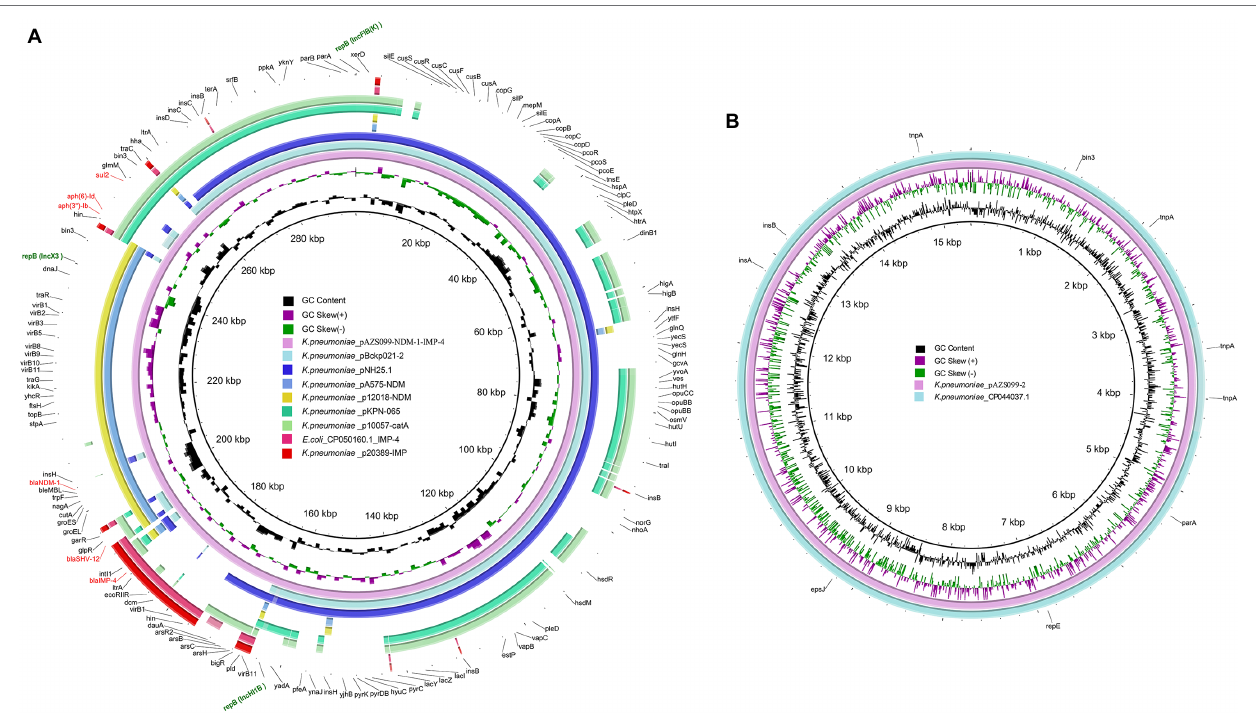
FIGURE 2 | Structural comparison of pAZS099-NDM-IMP and pAZS099-2. (A) Structural comparison of pAZS099-NDM-IMP and eight plasmids pNH25.1 (CP024875.1), pBckp021-2 (CP050836.1), p20389-IMP (MH909337.1), CP050160.1_IMP-4, pA575-NDM (MH917283.1), p12018-NDM (MH909343.1), pKPN-065